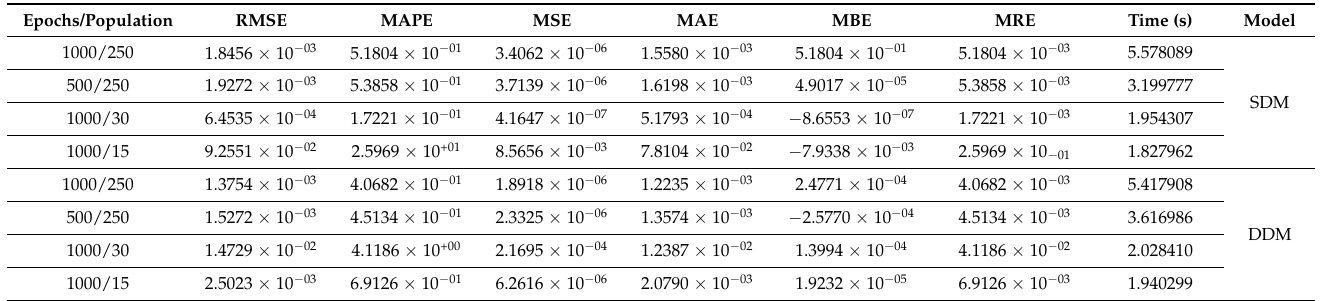
Table 22. Influence of the epochs and population on the statistical tests, monocrystalline silicon photovoltaic cell.